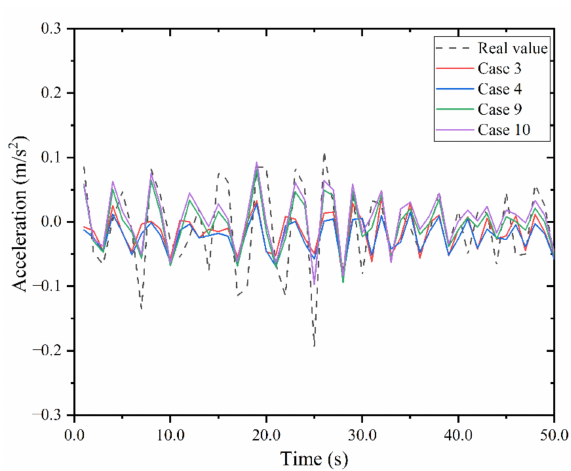
Figure 7. Predicted midship